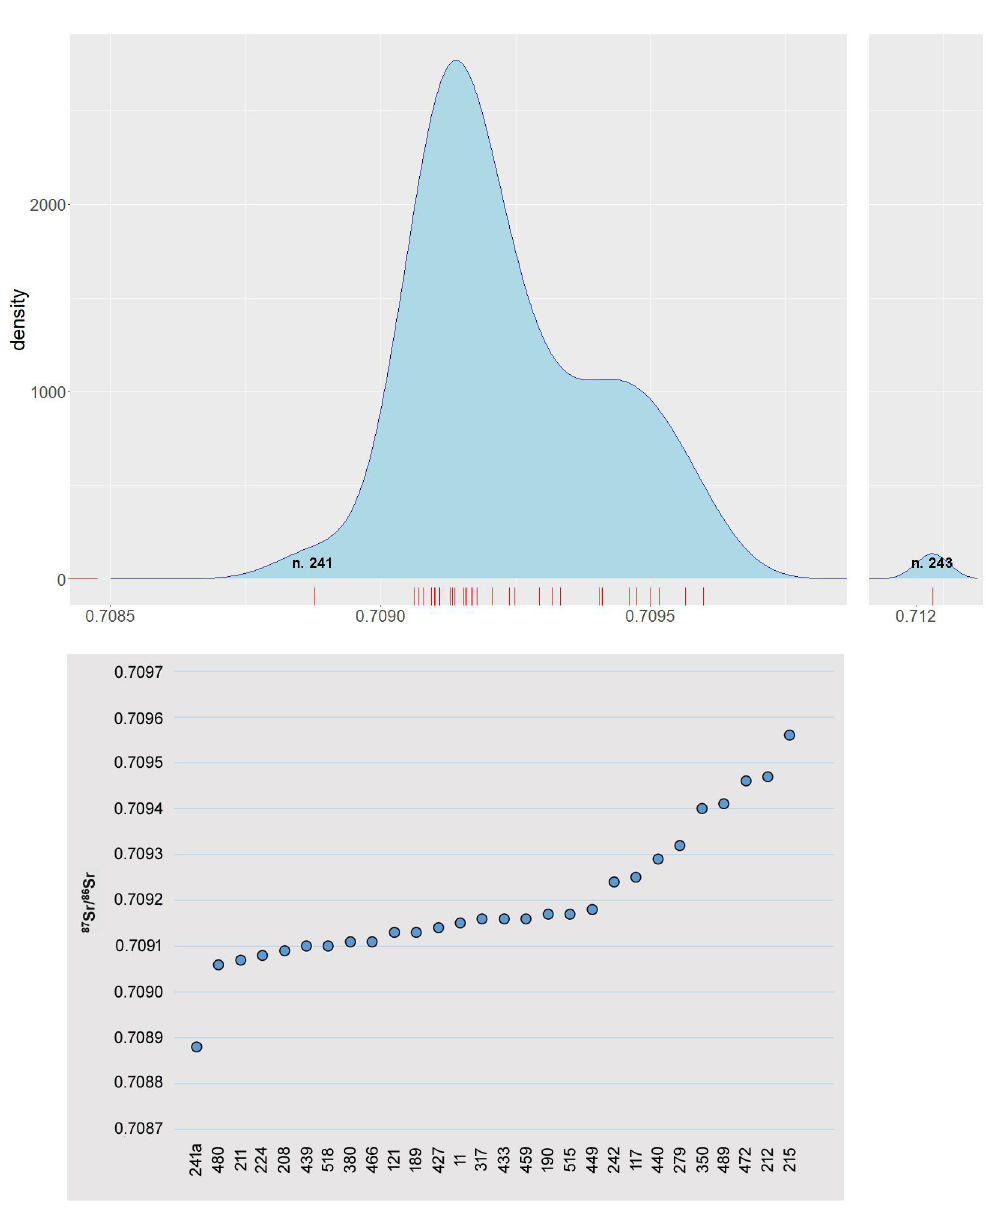
Fig 6. Density and scatter plots. Distribution of the 87 Sr/ 86 Sr values in the human sample. Each red bar in the density plot on the x-axis is a human sample. Outliers (n. 241 and n. 243) are highlighted.